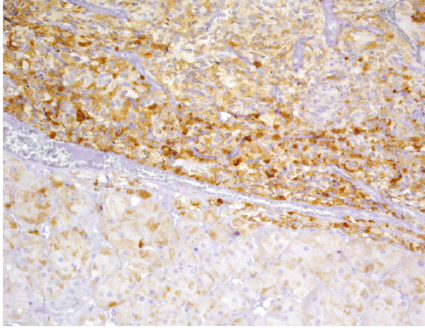
Figure 3: Positive Immunostaining for ACTH compatible with ectopic ACTH secretion by the tumor.